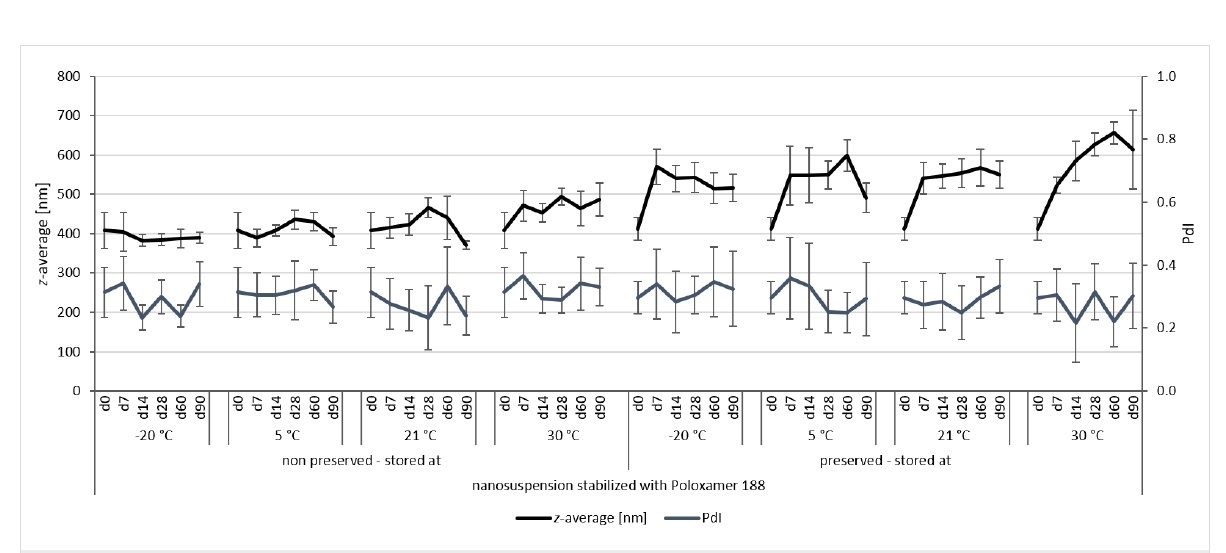
Figure 6: Physical stability during three months of storage at different storage temperatures for the nanosuspensions stabilized with Poloxamer 188 (DLS